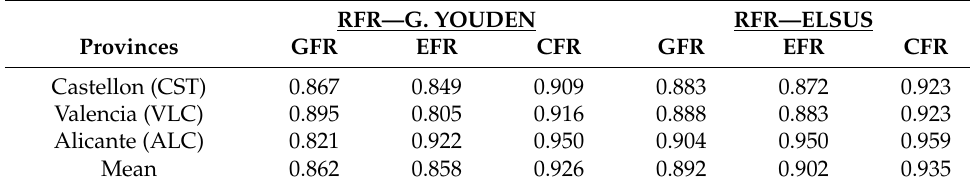
Table 9. Kappa values from the comparison of RFR maps with other maps.